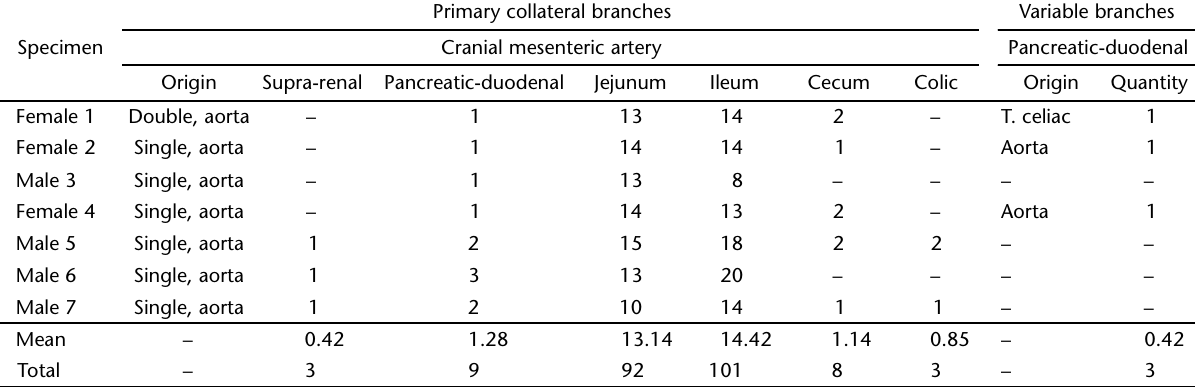
Table II. Quantitative data of collateral by intestinal sequences dependent on the cranial mesenteric artery and other variable branches of T. tetradactyla, according to specimen and sex. (T. celiac) Celiac trunk artery. Specimen